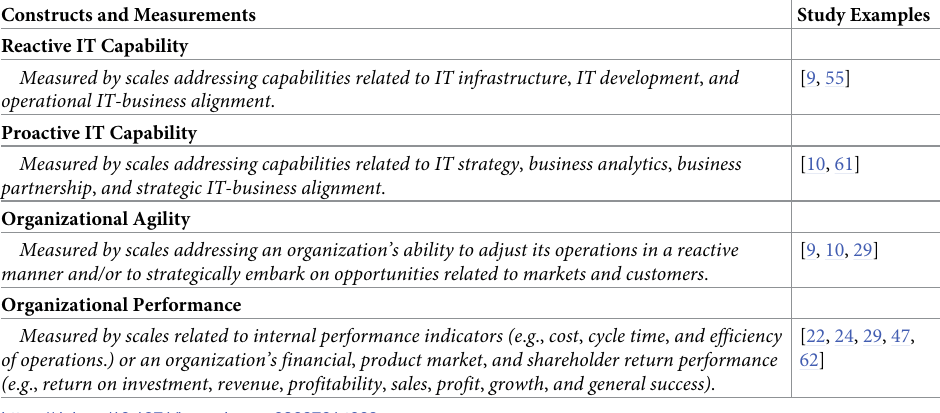
Table 3. Measurements of the focal constructs included in the